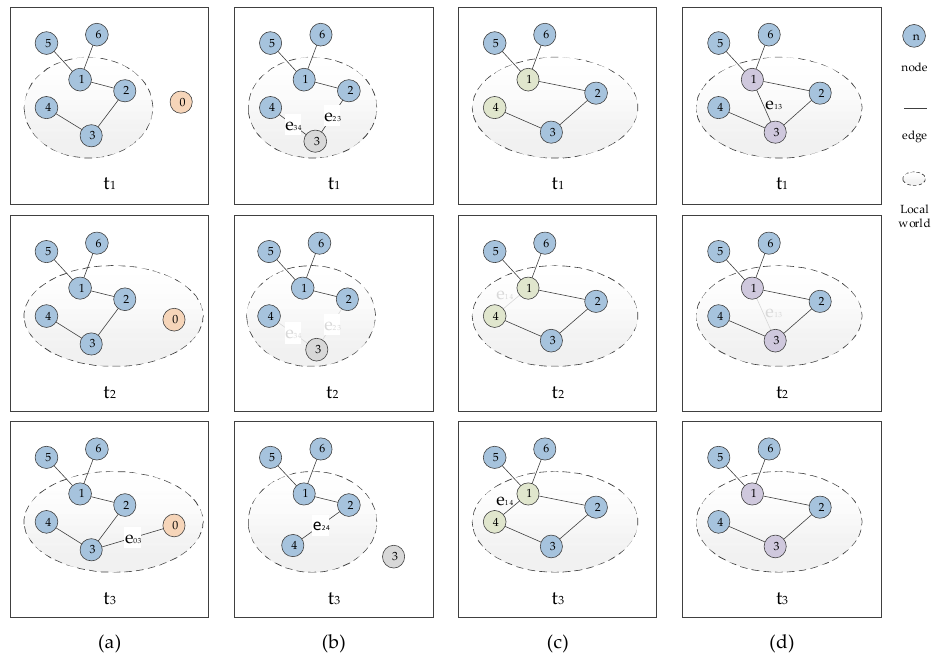
Figure 2. Local-world evolution mechanism: ( a ) Node increase mechanism; ( b ) Node deletion mechanism; ( c ) Edge increase mechanism; ( d ) Edge deletion mechanism.